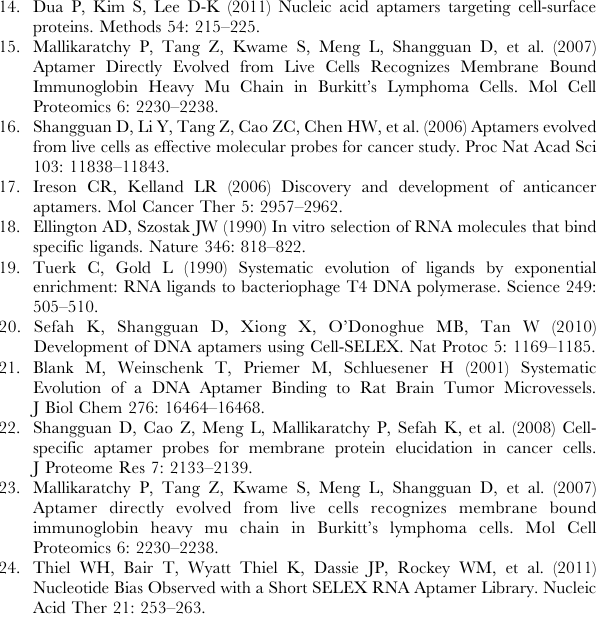
Figure S3 The binding affinity of aptamers GBM128